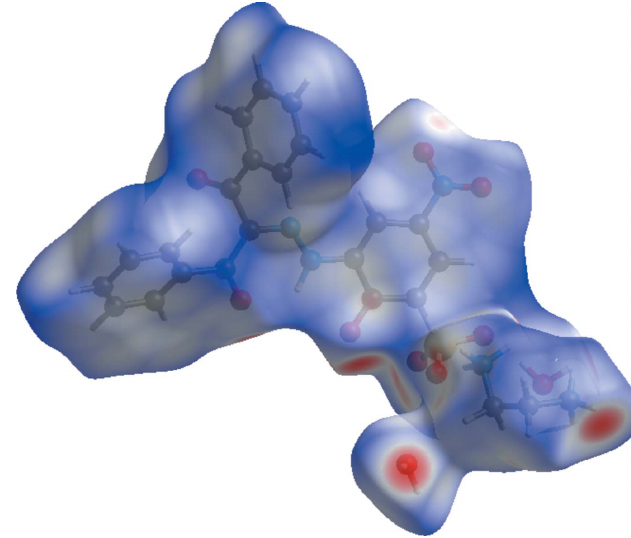
Figure 3 The Hirshfeld surface of the title compound mapped with d norm .